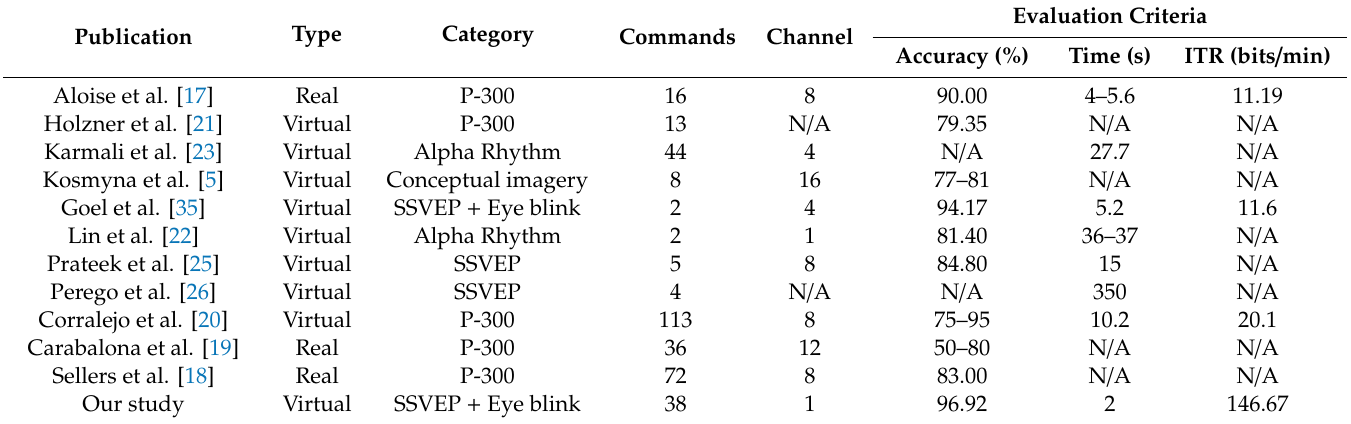
Table 1. Summary of related works on BCI-based home automation